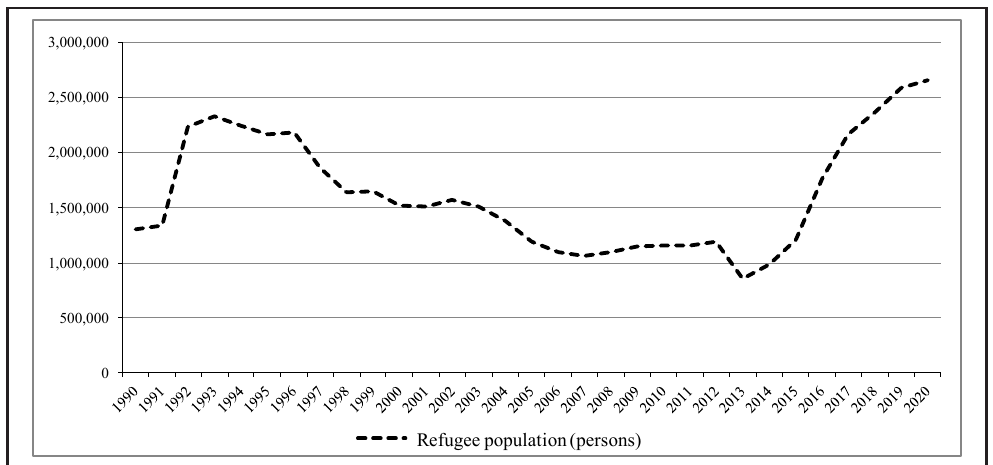
Figure 1 Refugee population in the EU from 1990 to